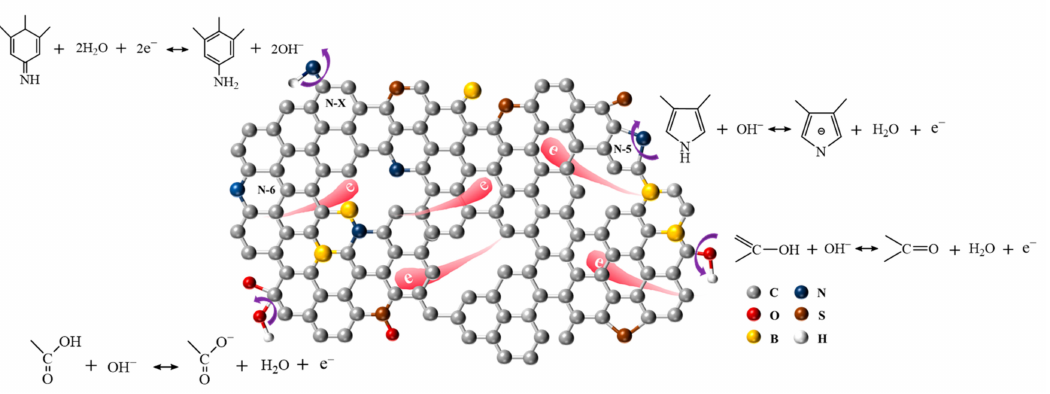
Figure 7. Effects of the N, O, B, and S heteroatoms on the increased capacitance of B/S-SC S